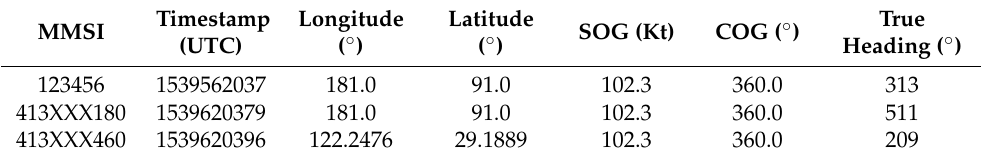
Table 2. Example of eliminated trajectory data